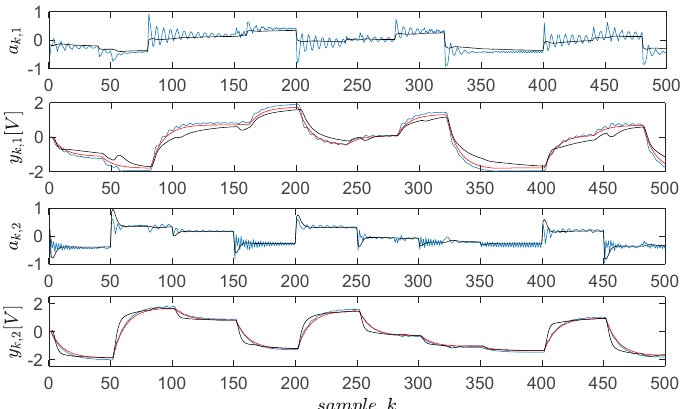
Figure 5. Tracking ORM results: 𝑎 (cid:3038),(cid:2869) , 𝑦 (cid:3038),(cid:2869) , 𝑎 (cid:3038),(cid:2870) , 𝑦 (cid:3038),(cid:2870) with AIVI (blue); 𝑎 (cid:3038),(cid:2869) , 𝑦 (cid:3038),(cid:2869) , 𝑎 (cid:3038),(cid:2870) , 𝑦 (cid:3038),(cid:2870) with PI Figure 5. Tracking ORM results: a k ,1 , y k ,1 , a k ,2 , y k ,2 with AIVI (blue); a k ,1 , y k ,1 , a k ,2 , y k ,2 with PI control Figure 5. Tracking ORM results: 𝑎 𝑘,1 , 𝑦 𝑘,1 , 𝑎 𝑘,2 , 𝑦 𝑘,2 with AIVI (blue); 𝑎 𝑘,1 , 𝑦 𝑘,1 , 𝑎 𝑘,2 , 𝑦 𝑘,2 with PI control (black); 𝑦 (cid:3038),(cid:2869)(cid:3040) , 𝑦 (cid:3038),(cid:2870)(cid:3040) (red). (black); y m , y m (red). control (black); 𝑦 𝑘,1𝑚 , 𝑦 𝑘,2𝑚 (red). k ,1 k ,2